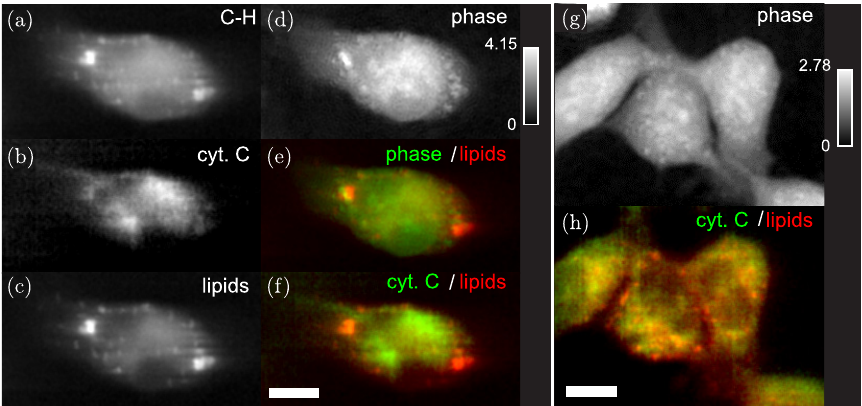
Fig. 4. Simultaneous QPM and Raman measurements on MH-S macrophage (a) – (f) and HeLa (g) and (h) cells. The source of image contrast are (a) c – h stretching band (2935 – 2955 cm (cid:1) 1 ), (b) cytochrome C band (740 – 780 cm (cid:1) 1 ), (c) lipid band (2860 – 2880 cm (cid:1) 1 ), (d) and (g) phase, (e), (f), (h) Overlay images. The phase dynamic range is given in radians, and scale bars are 5 (cid:1)